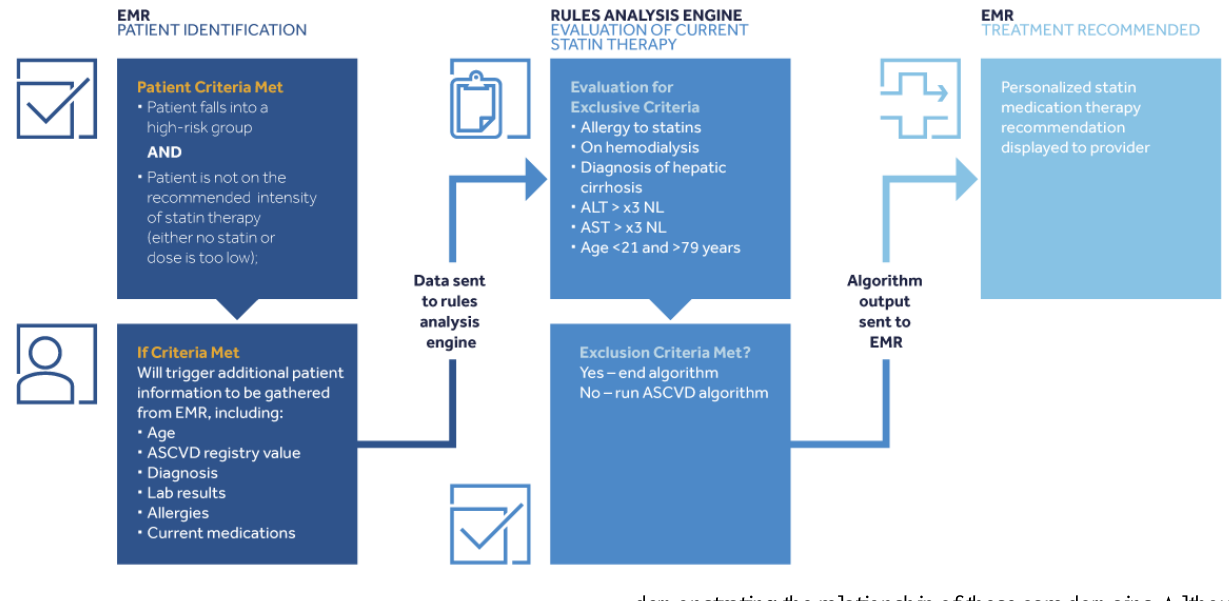
Figure 3. An atherosclerotic cardiovascular disease risk scoring algorithm to classify patients according to their risk group. ALT: alanine aminotransferase;